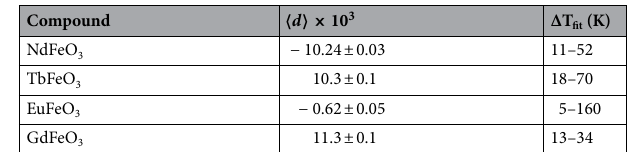
Table 1. Mean R –Fe interaction parameter (cid:31) d (cid:30) calculated from the best fit of Eq. (1) to the experimental data shown in Fig. 1a–d, and the temperature interval where the fit is